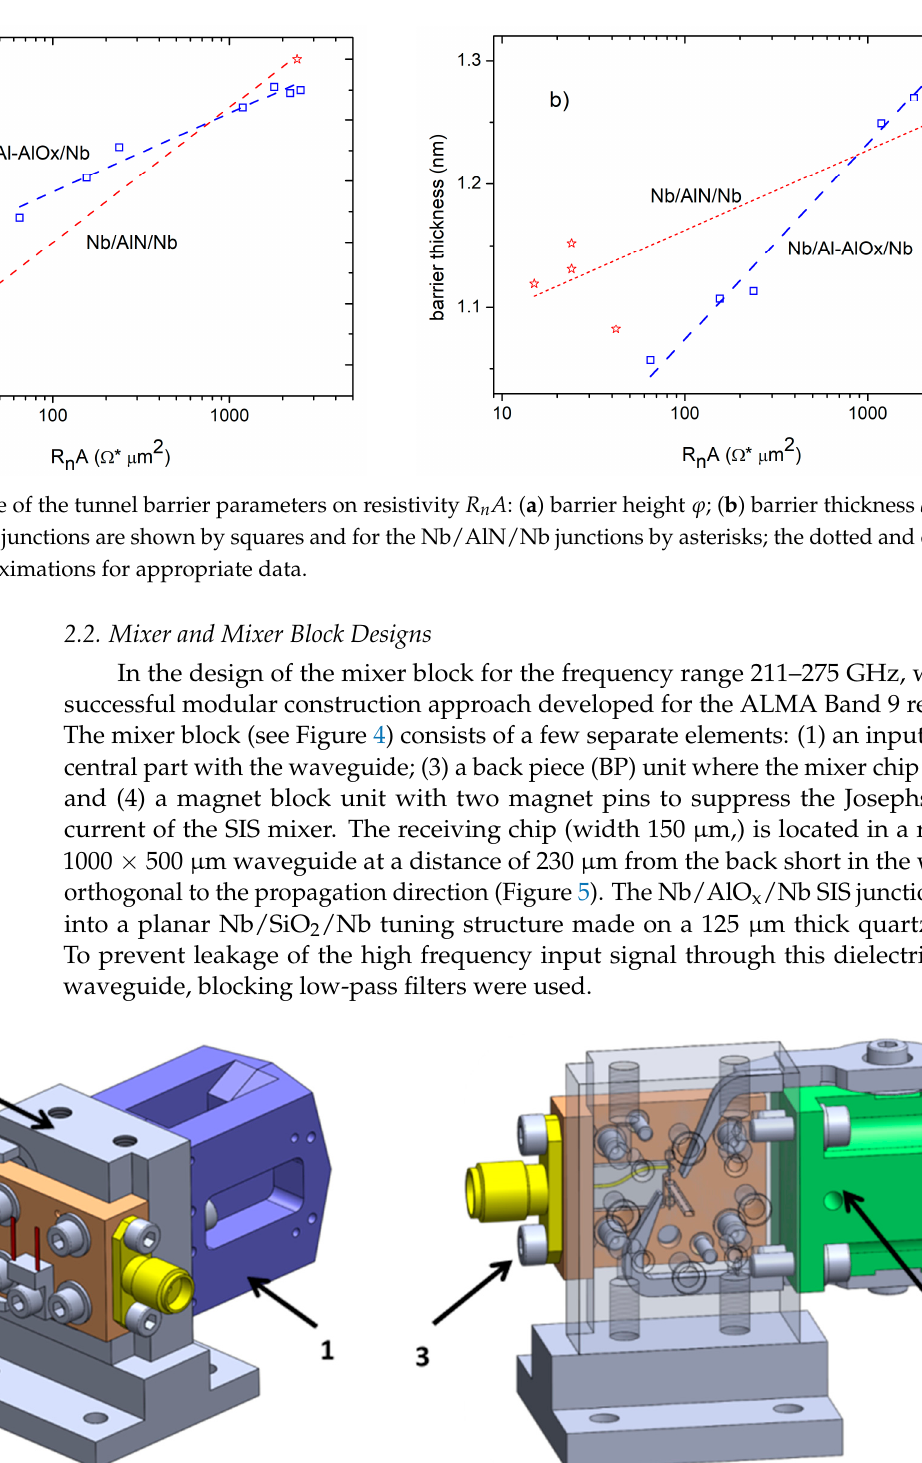
Figure 4. A 3D model of the mixer block for the frequency range 211 – 275 GHz; all main parts are shown: (1) input horn, (2) central part with the waveguide, (3) back piece with mixer chip, (4) magnet block unit.